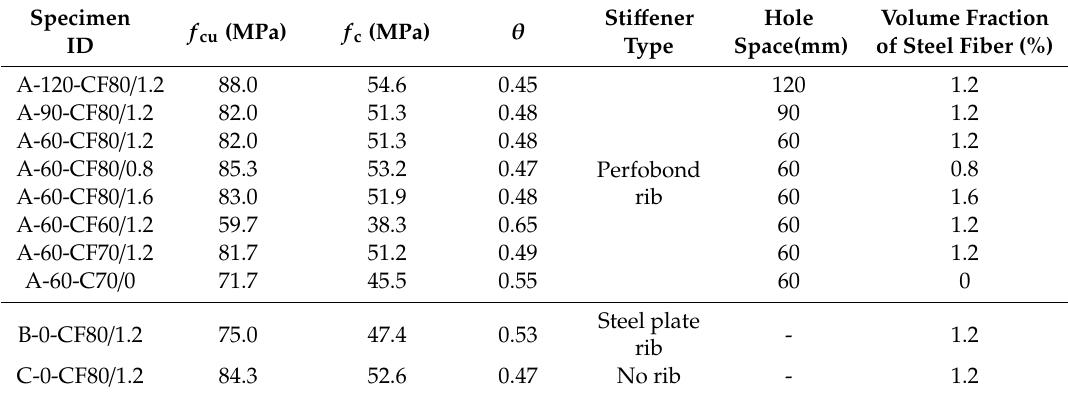
Table 2. Mechanical properties and sti ff ener of the